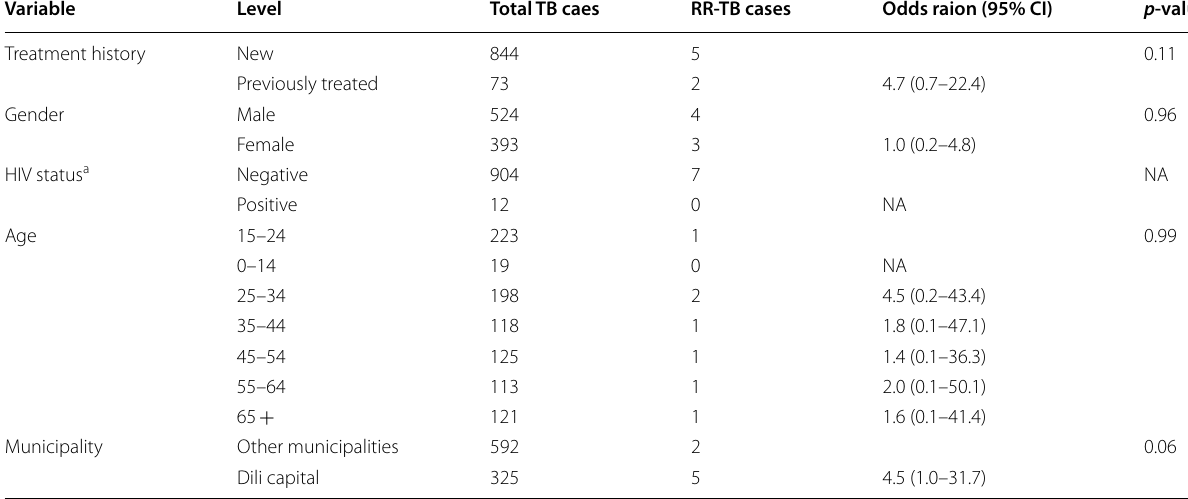
Univariate logistic regression analyses of key demographic and clinical variables as potential predictors of rifampicin resistance. Analyses were adjusted by treatment history. Variable levels with zero cases were excluded from the analyses; consequently, no analysis was conducted for HIV, but numbers of rifampicin resistant cases disaggregated by HIV status are included in the table for reference a HIV status was missing for one